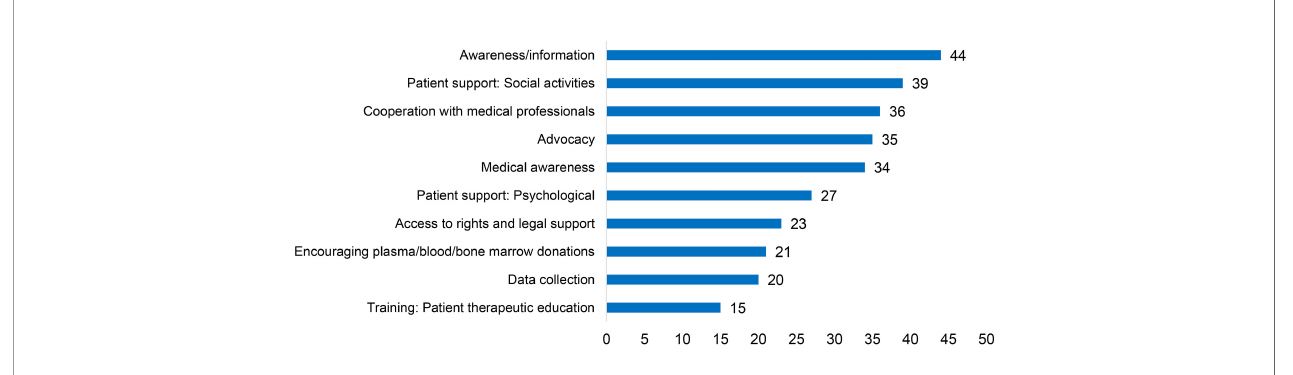
FIGURE 12 | Main working areas for PID patient organisations